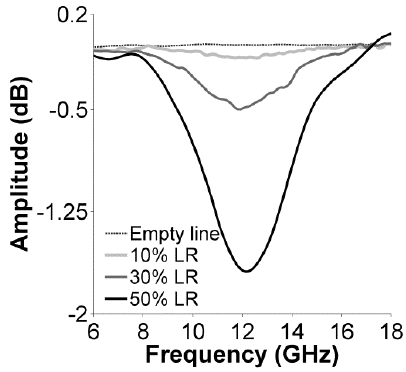
Table 3. Dependence of FMR on M s for various alloys. M s values were determined by SQUID measurements.